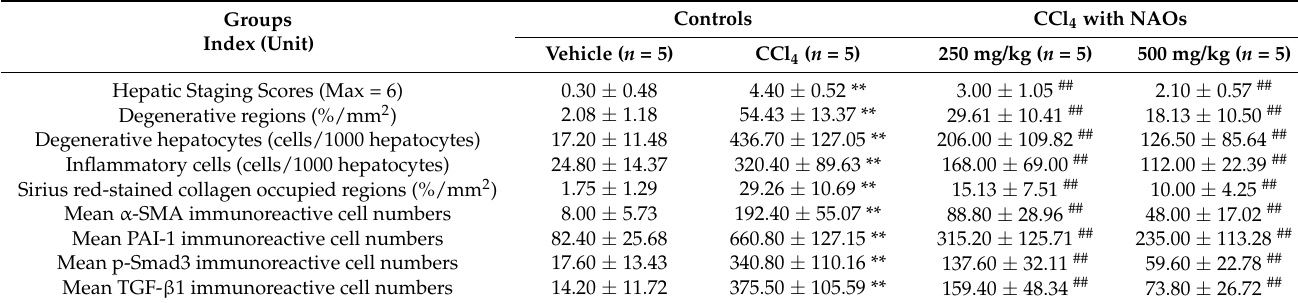
Table 1. Histomorphometrical analysis of hepatic tissues from vehicle or CCl4-treated mice.